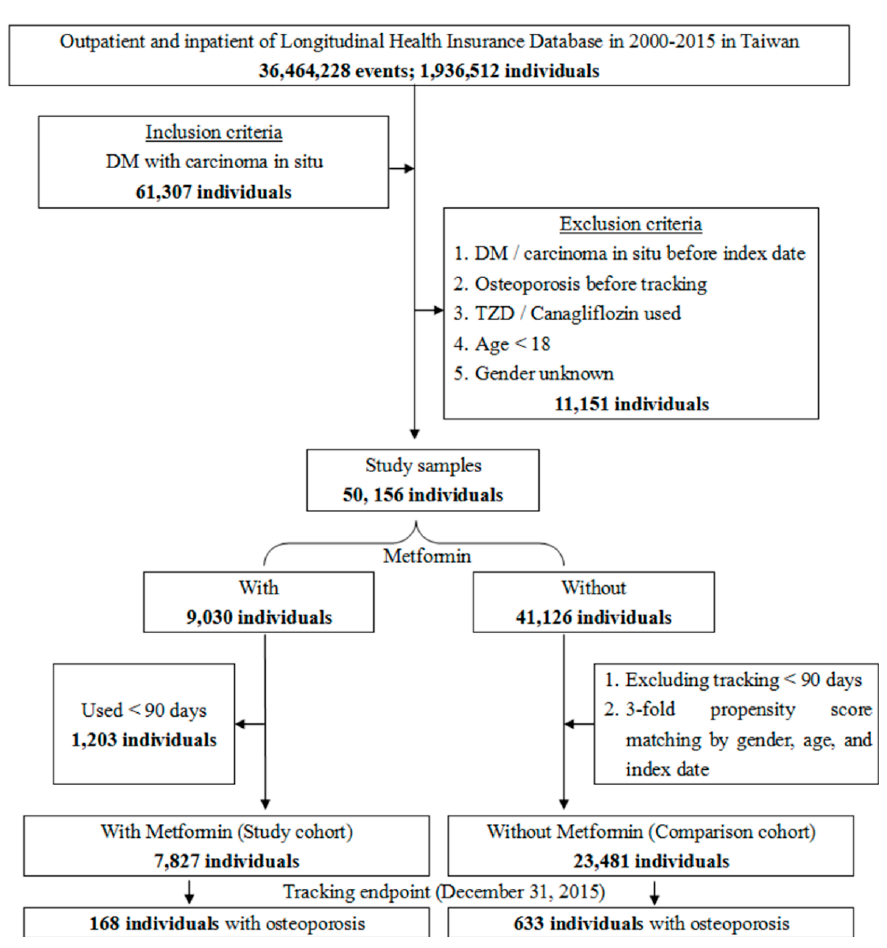
Figure 1. Flowchart of study patient selection from the National Health Insurance Research Database in Taiwan. DM—Diabetes mellitus: ICD-9-CM 250; Carcinoma in situ: ICD-9-CM 230–234; Osteoporosis: ICD-9-CM 733.0; Metformin: ≥ 90 days. J. Clin. Med. 2020 , 9 , x FOR PEER REVIEW